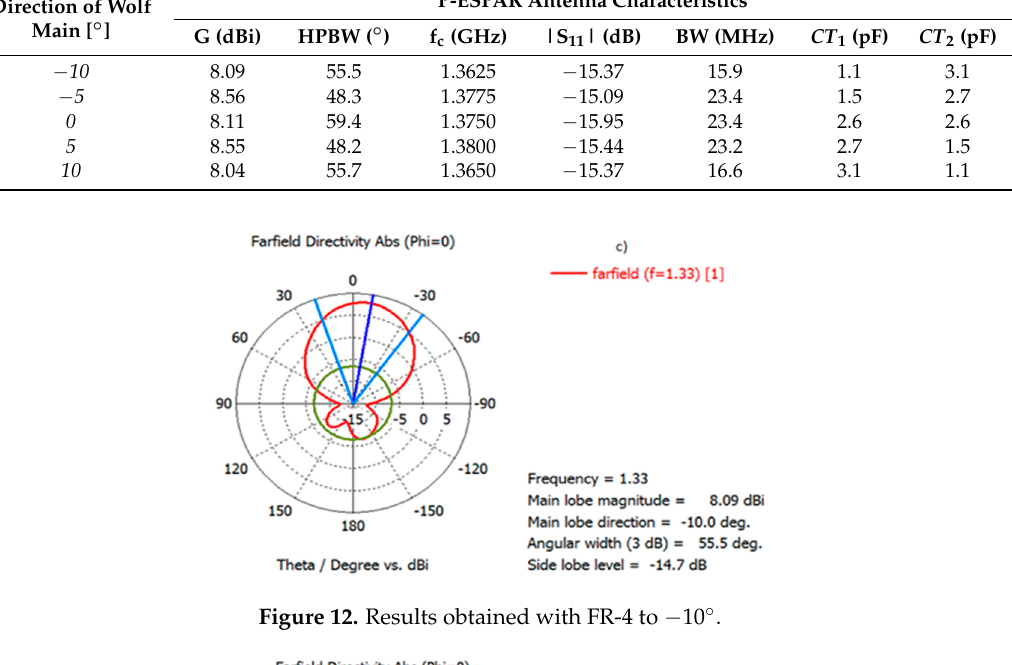
Figure 12. Results obtained with FR-4 to − 10°.